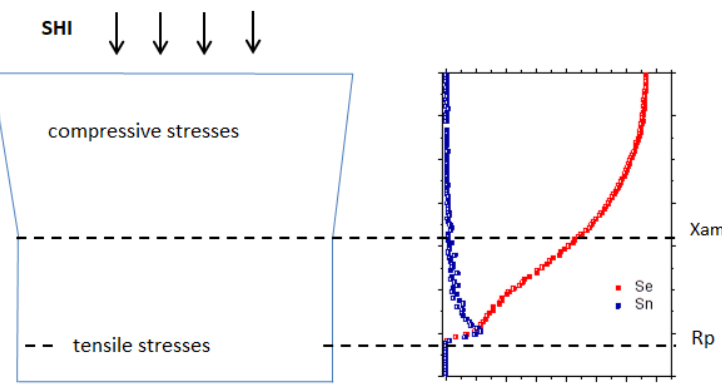
Figure 5. Schematic drawing of SHI irradiated target and energy loss profiles.